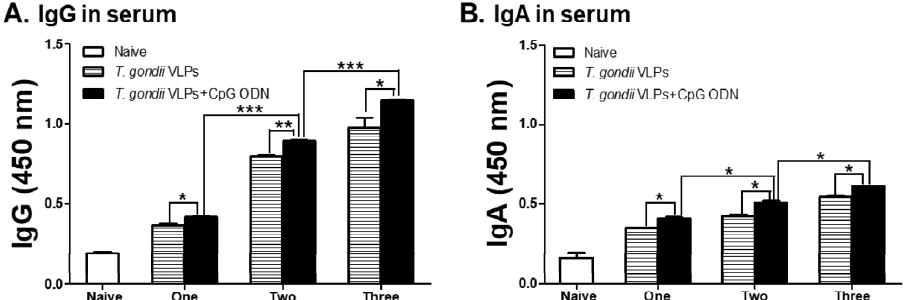
Figure 1. Immunization with CpG-ODN-adjuvanted Toxoplasma gondii virus-like particles (VLPs) enhances T. gondii -specific IgG ( A ) and IgA ( B ) antibody production in the sera upon one, two, and three immunizations. Groups of mice ( n = 6 per group) were intranasally immunized one, two, or three times with T. gondii VLPs alone or CpG-ODN-adjuvanted T. gondii VLP vaccine. Booster vaccinations were provided at 4-week intervals. Mouse sera were collected at 4 weeks after each immunization to detect the levels of IgG ( A ) and IgA ( B ) antibodies by ELISA. Results are presented as mean ± SD and statistical significances were denoted using asterisks (* p < 0.05, ** p < 0.01, and *** p < 0.001).